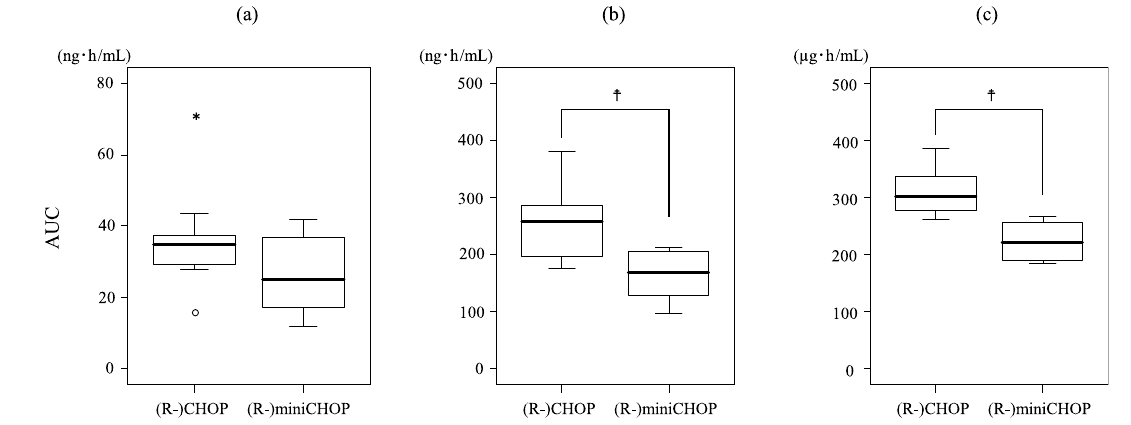
Figure 2. Comparison of AUC of cytotoxic anticancer drugs between (R-)CHOP and (R-)miniCHOP groups. a vincristine; b doxorubicin; c cyclophosphamide. The box spans data between 2 quartiles (interquartile range [IQR]), with the median represented as a bold horizontal line. The ends of the whiskers (vertical lines) represent the smallest and largest values that were not outliers. Outliers (circles) are values between 1.5 and 3 IQRs from the end of the box. Values more than 3 IQRs from the end of the box are defined as extreme (asterisk). AUC, area under the plasma concentration–time curve; AUC of vincristine and doxorubicin, AUC 1.5–25.5 ; AUC of cyclophosphamide, AUC 1–25 ; ☨ P <